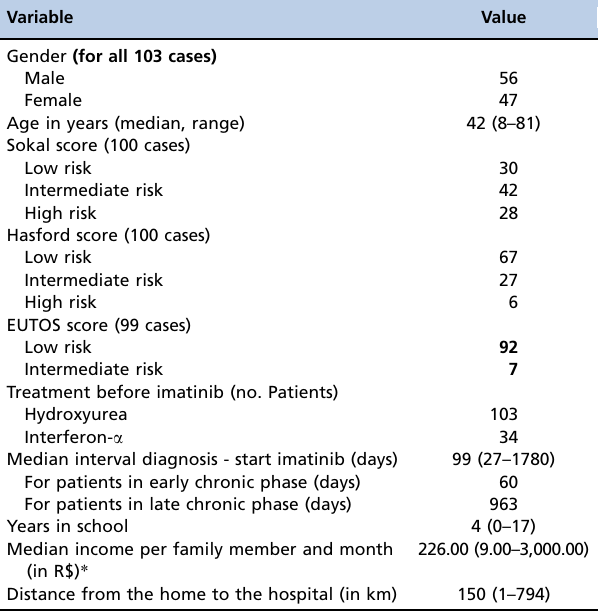
Table 1 - Features of the patients at